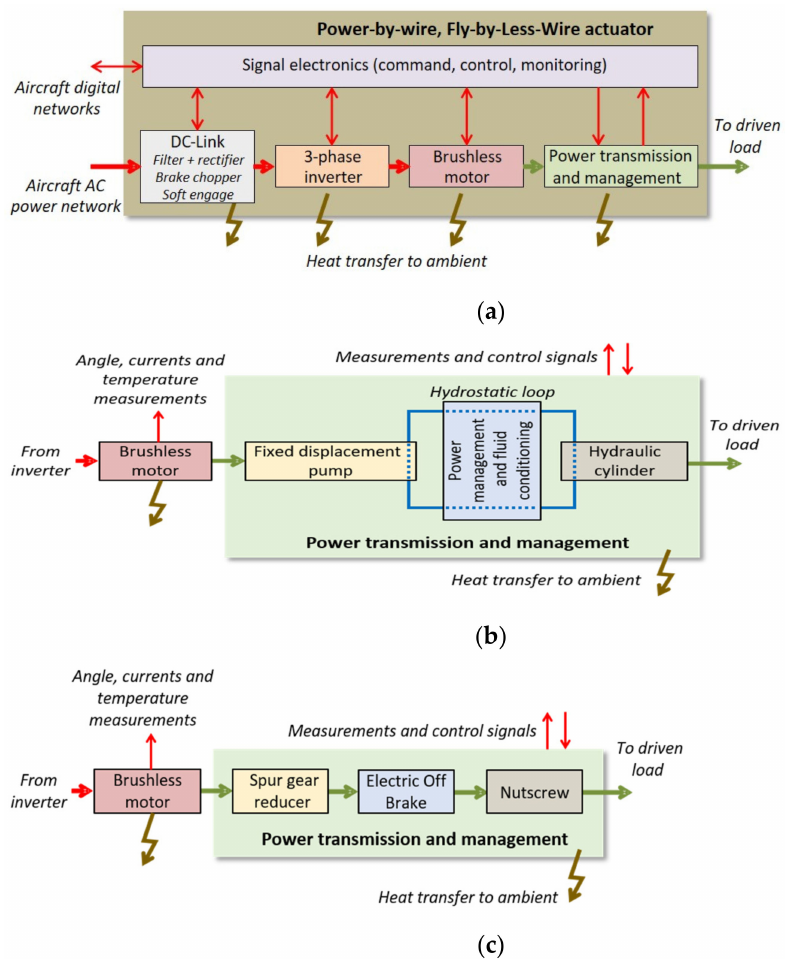
Figure 6. Architectures of power-by-wire actuators: ( a ) Generic architecture with focus on power flows; ( b ) Power transmission and management in EHAs; ( c ) Example of power transmission and management in